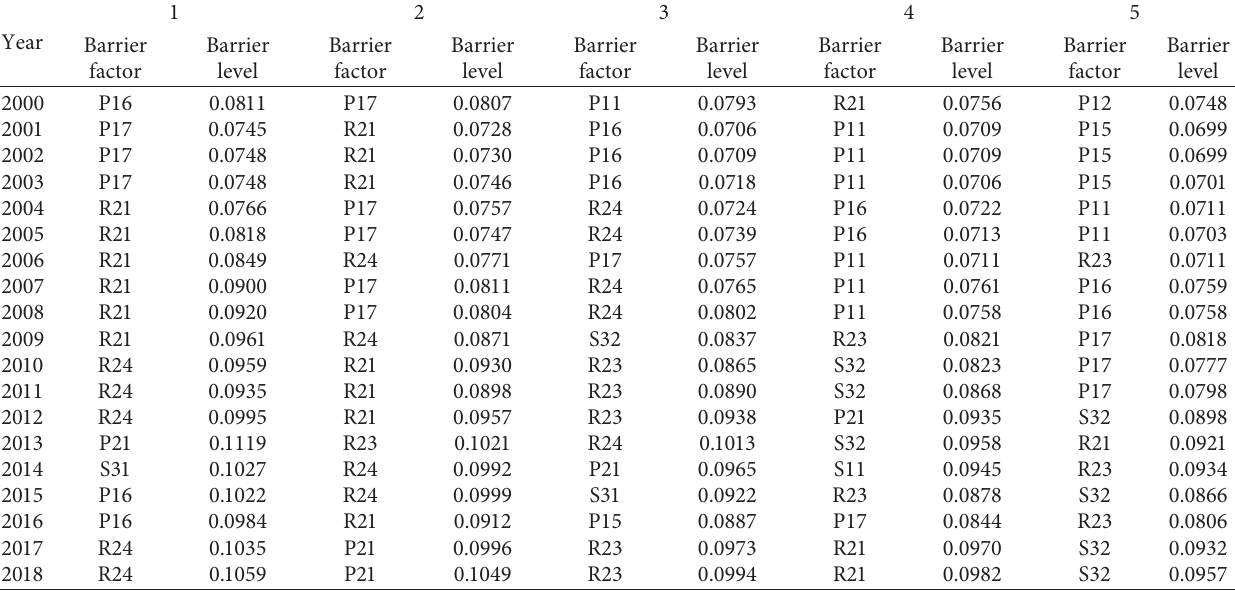
Table 3: Main constraint factors of industrial ecosystem development of 14 cities in Liaoning Province during